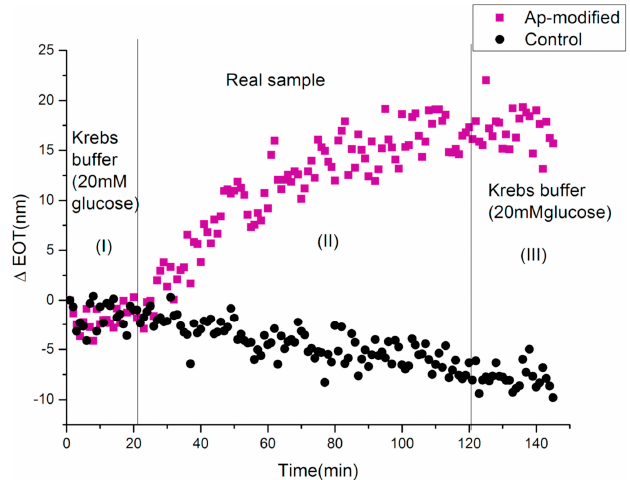
Figure 4. Sensorgram for the detection of insulin secreted by human islets upon stimulation with 20 mM glucose for 2 h in Krebs buffer using IRS. Reproduced with permission from [63].